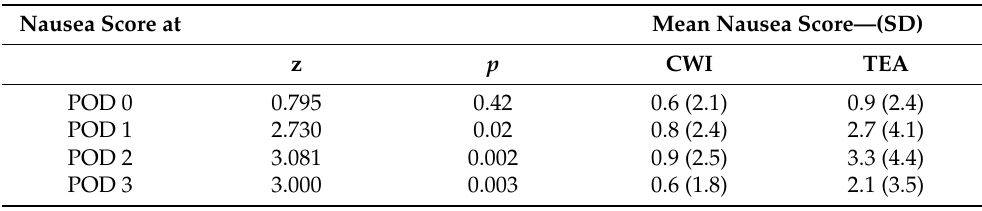
Table 4. Impact of postoperative pain management technic on patients’ self-reported nausea (ranging from 0 to 10) on different postoperative days (PODs).